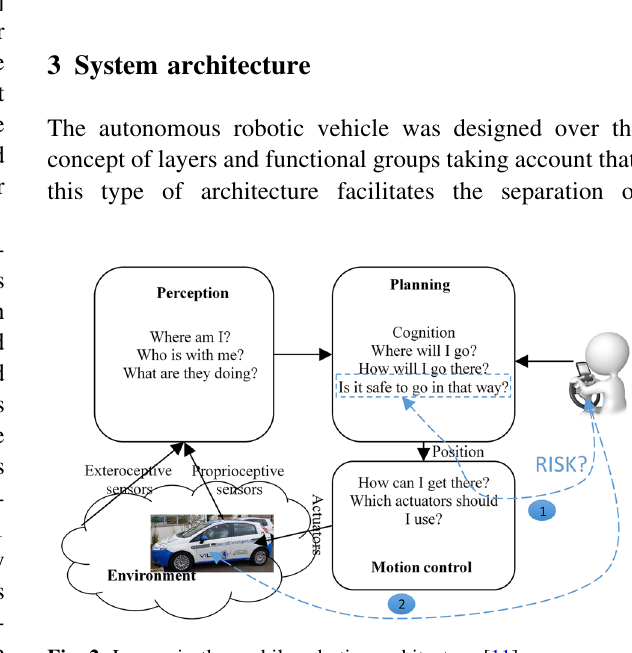
Fig. 2 Layers in the mobile robotics architecture